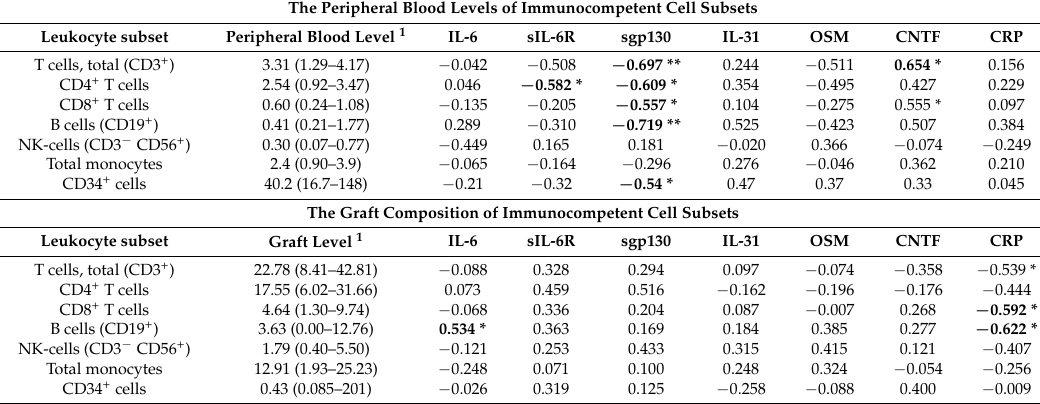
CD8 + T cells B cells (CD19 + ) 3.63 (0.00–12.76) Total monocytes 1 Peripheral blood levels: The vertical column presents the cell subset, the horizontal line the serum soluble mediator.